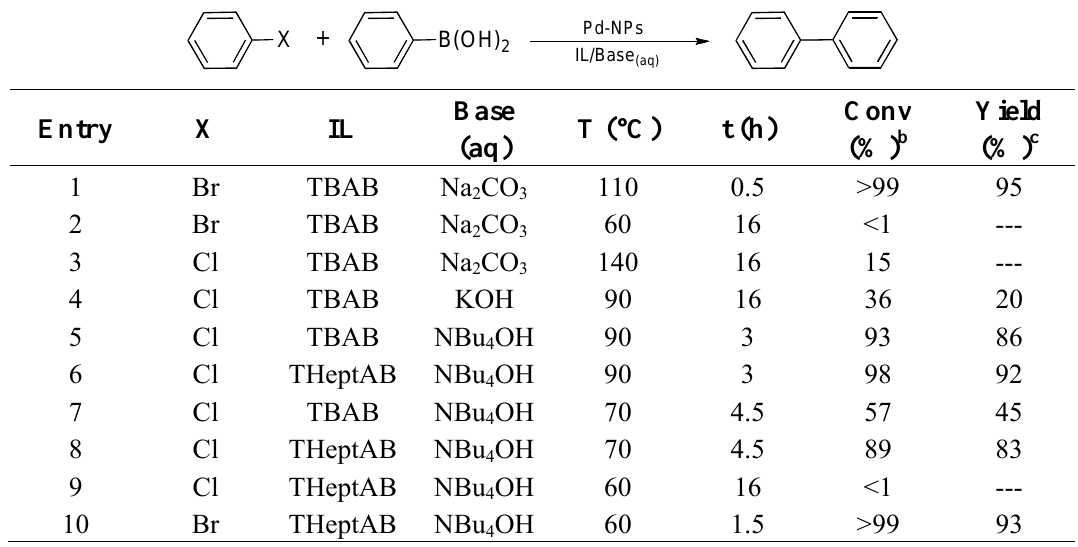
Table 2. Suzuki cross-coupling reactions catalysed by Pd-NPs in ILs [57]. a